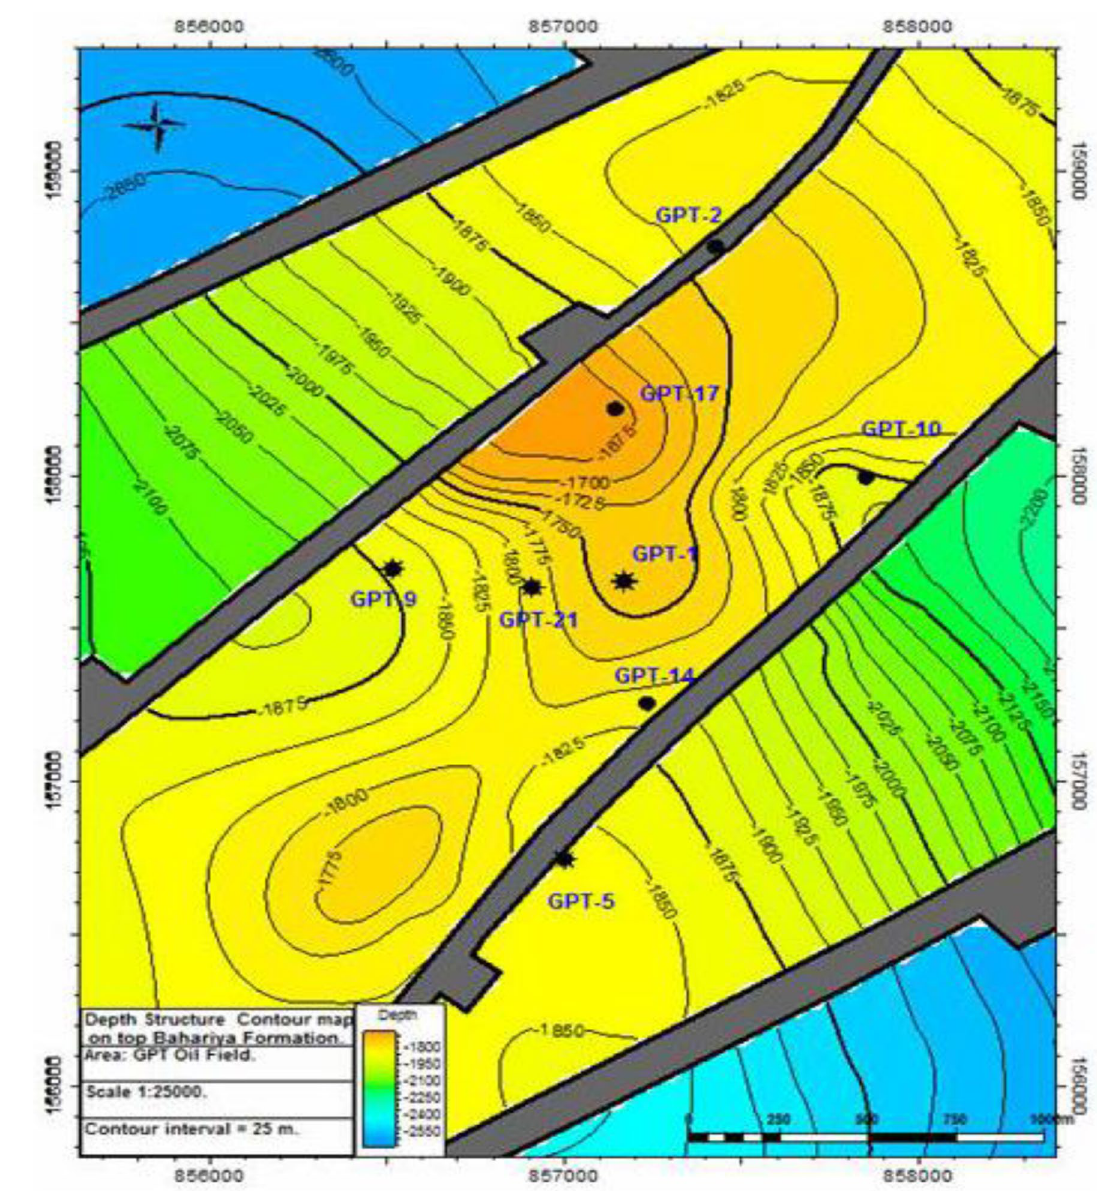
Fig. 7 Depth structure contour map of top of the Bahariya